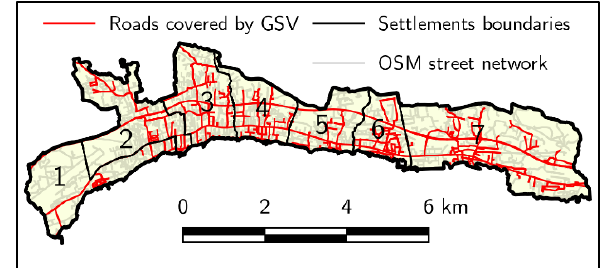
Figure 2. GSV coverage, OSM street network, and settlements urban area boundaries (settlement numbers correspond to